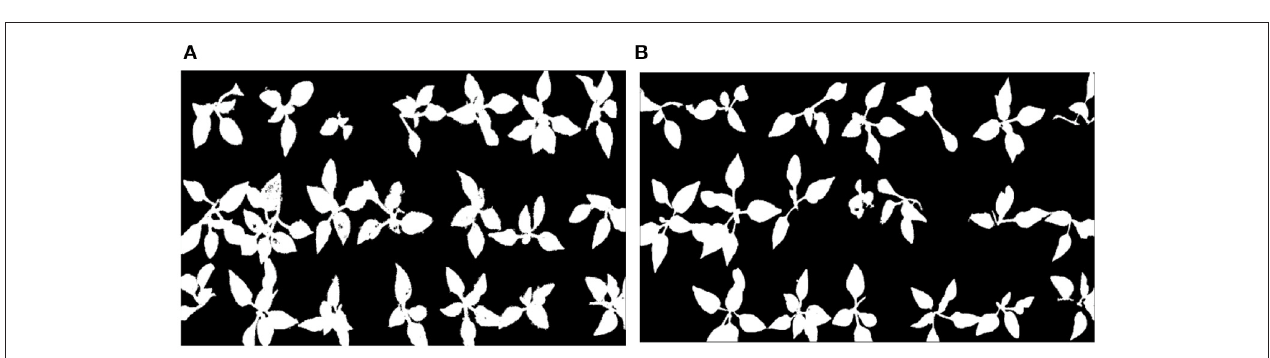
FIGURE 6 | Image denoising by 3D block-matching algorithm